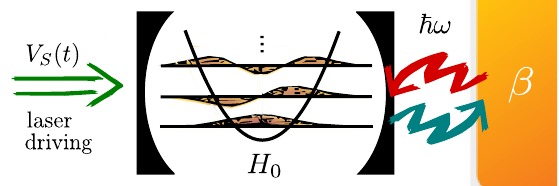
t Þ while in S ð